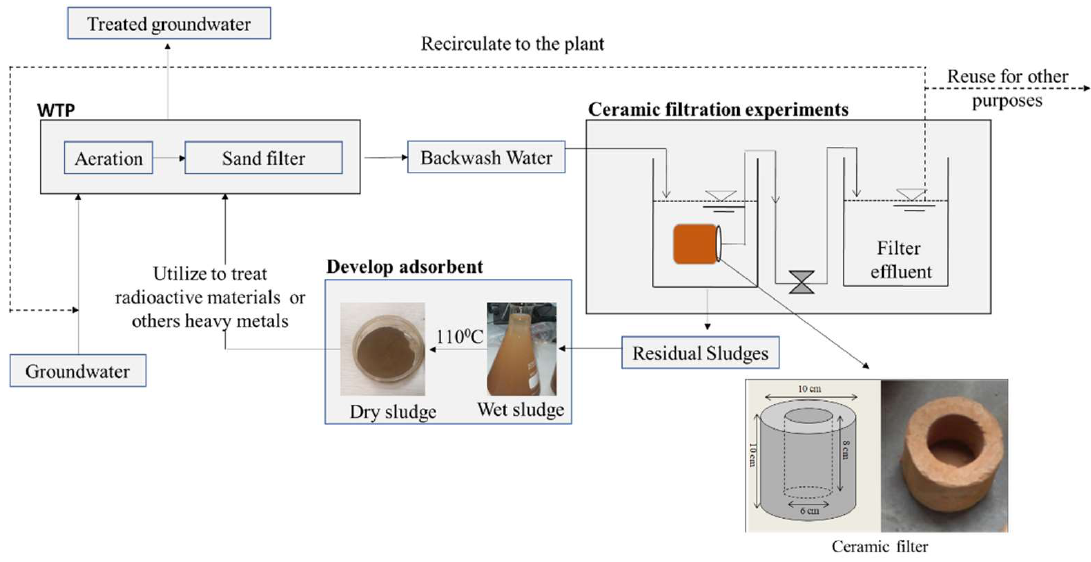
Figure 1. A conceptual model for sustainable BW management system.